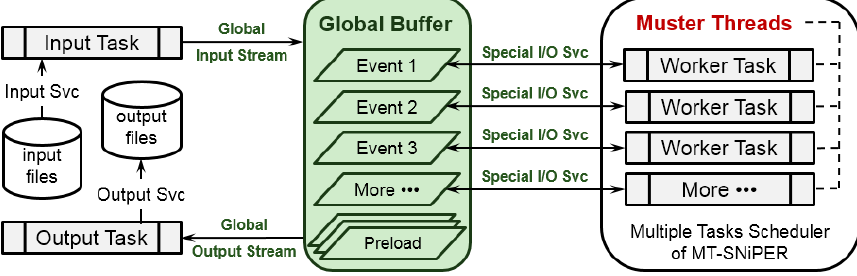
Fig. 1. The schematic diagram of